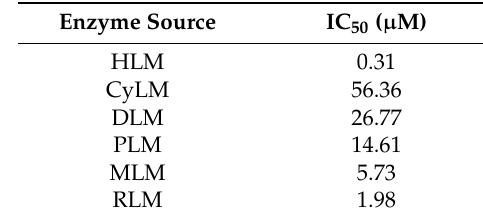
Table 1. The IC 50 values of furafylline against NCMN -O- demethylation in liver microsomes from di ff erent